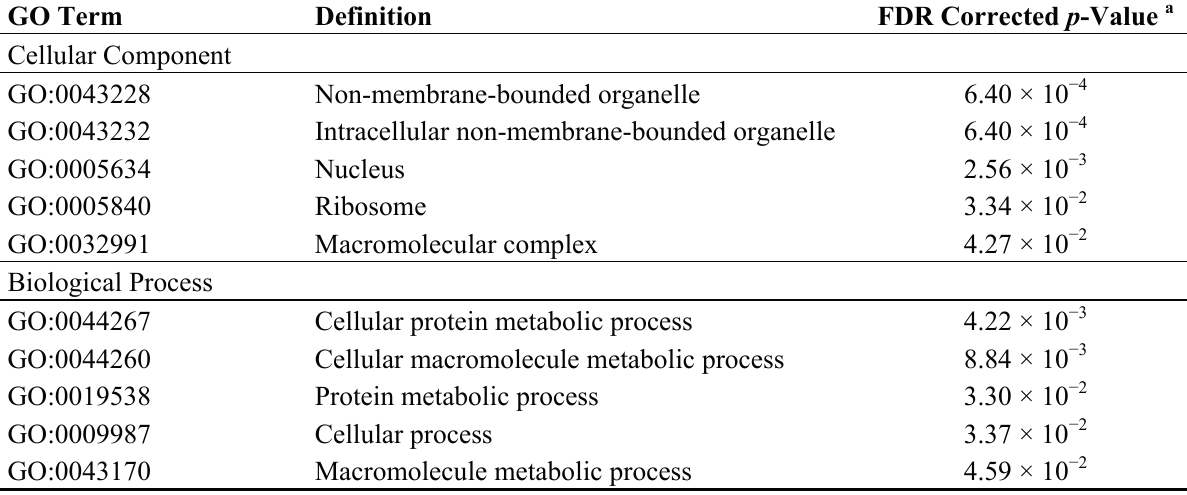
Table 4. Significant GO terms of DGs in the gene ontology (GO) annotation analysis of cellular component and biological process. a p -values calculated using a hypergeometric test-determines if the number of times that a GO term appears in the cluster is significant, relative to its occurrence in the genome.